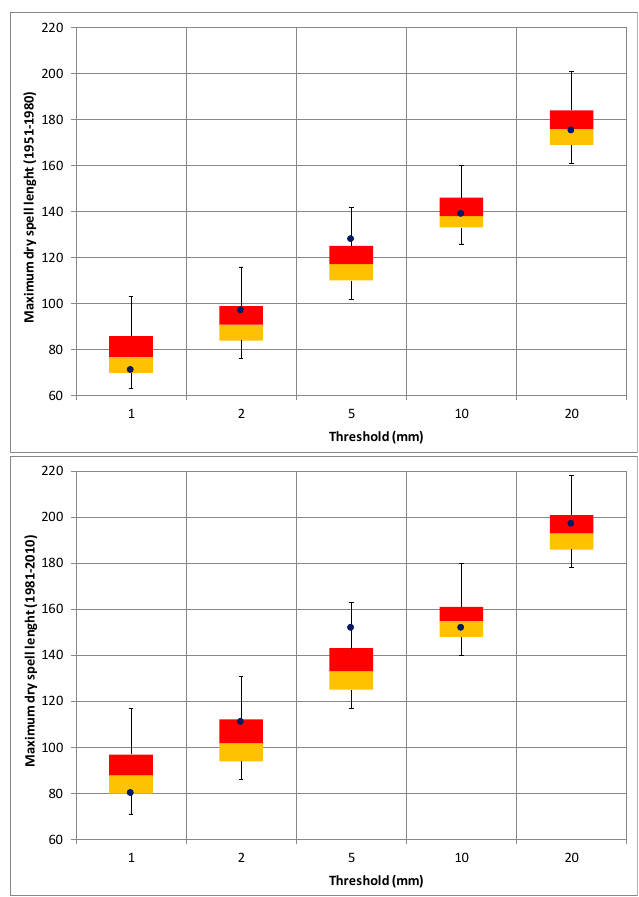
Figure 5. Comparison between simulated (boxplots) and observed values (blue dots) of the maximum dry spell length evaluated for the different thresholds for each 30-year period for the Cosenza rain gauge. (Bottom and top of the box: first and third quartiles. Band inside the box: median, second quartile. Ends of the whiskers: 5% and 95% percentiles. Yellow color: values below the median. Red color: values above the median.).